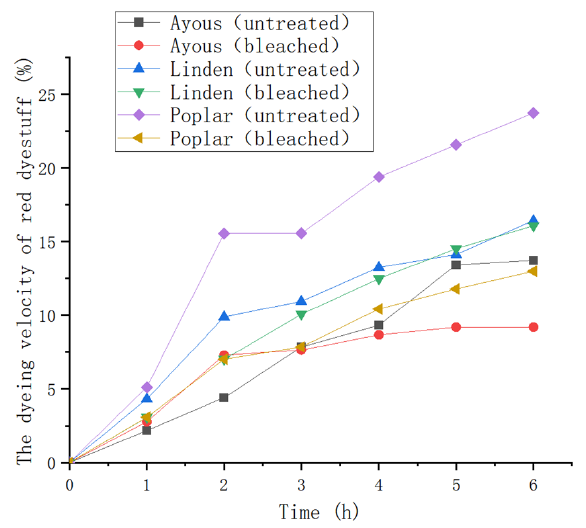
Figure 5. Dyeing rate of red dyestuff.